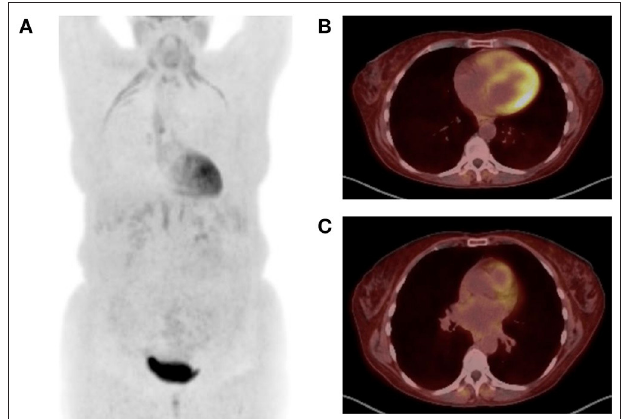
FIGURE 3 | Positron emission tomography (PET) images are shown from a 52-year-old woman with emphysema and associated Group 3 pulmonary hypertension presenting with acute exacerbation. 9.78 mCi 18 F-FDG injected at 119 mg/dl blood glucose level. Image acquisition 57 mins post injection. (A) Maximum intensity projection image demonstrates FDG uptake in the diaphragm, infrahyoid muscles, and intercostal muscles consistent with increased work of breathing noted during examination. There is also diffuse subcutaneous uptake, reflecting treatment with corticosteroids during the exacerbation. (B) Transaxial images at the midventricular level demonstrate abnormal uptake in the right ventricle. (C) Transaxial images at the level of the main pulmonary artery (mPA) demonstrate enlarged mPA and abnormal FDG uptake in the right ventricular outflow